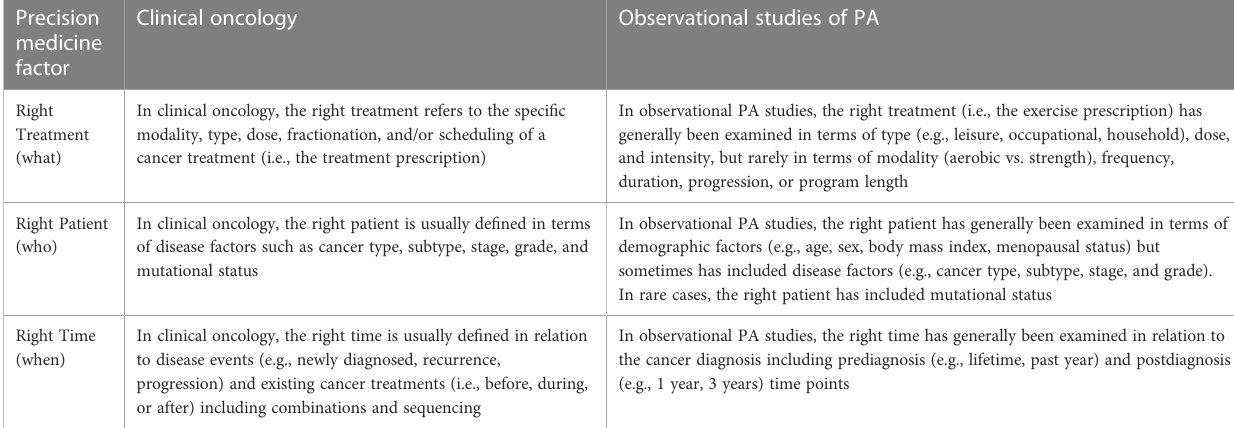
TABLE 7 Precision medicine in clinical oncology versus observational studies of physical activity and cancer outcomes. Precision Clinical medicine factor